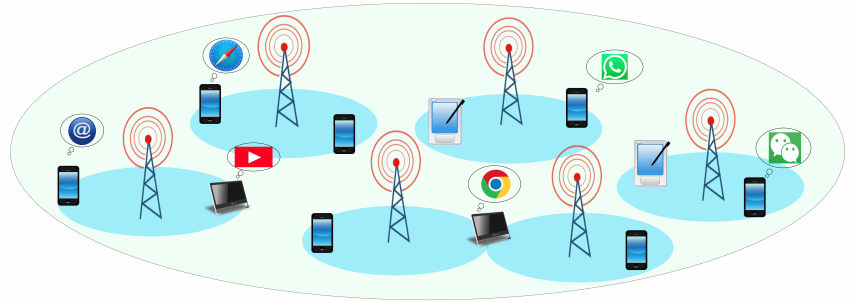
Figure 1. Main service types of cellular network